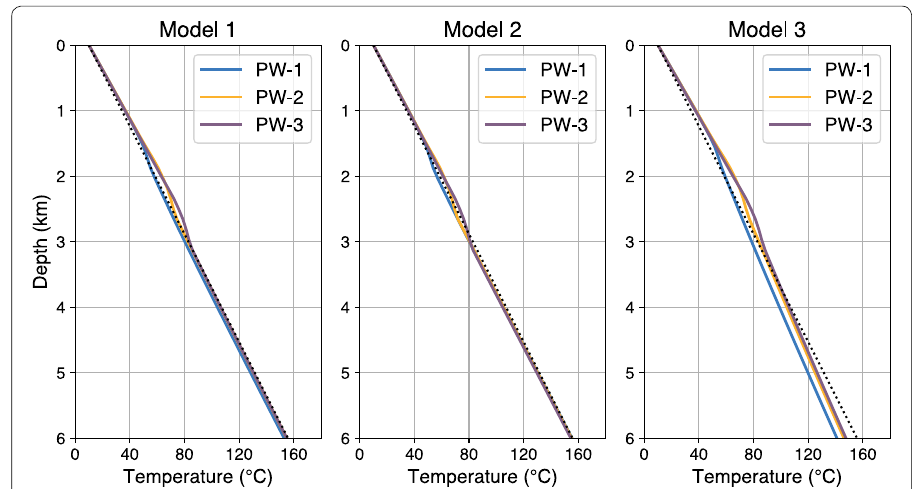
Fig. 13 Temperature changes along three vertical profiles. Temperature changes along three vertical profiles in Fig. 11 showing the thermal blanket effect of the sedimentary rocks (the sedimentary cover is thinnest at PW-1 and thickest at PW-3). Dashed lines show a 24.3 ◦ C /km